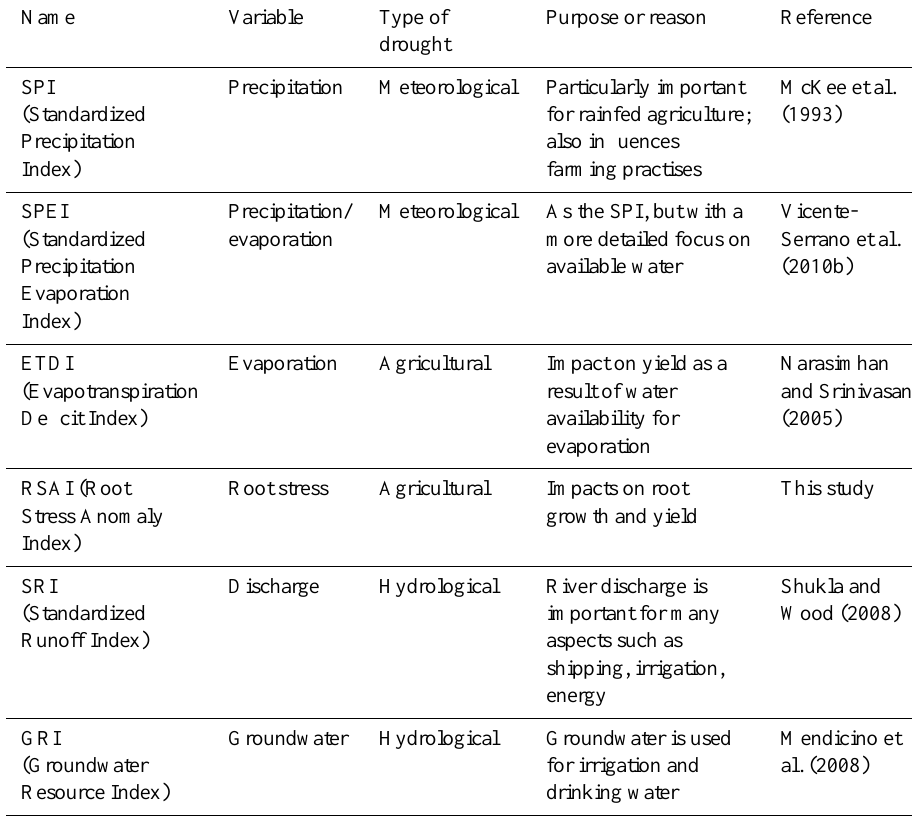
Table 1. Drought indicators derived in this